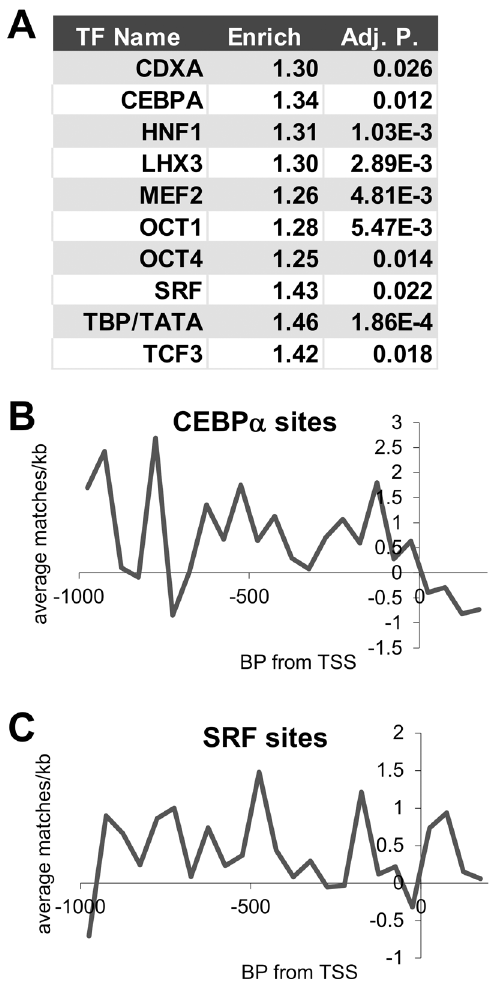
Fig 5. Distinct TF binding site enrichments in hEC genes regulated by E2/ER α rapid signaling. (A) Fold enrichments, and median adjusted p. values for every TF represented by more than one significantly- enriched TFBS matrix (adjusted p. value < 0.05 and enrichment over background, non-regulated gene promoters > 1.15), and which showed at least a 1.05-fold enrichment for all its cognate matrices. (B & C) Plots of the average frequency of matches to the significantly enriched CEBP and SRF matrices versus the TSSes of WT hEC E2 up-regulated genes, relative to the background from unregulated gene